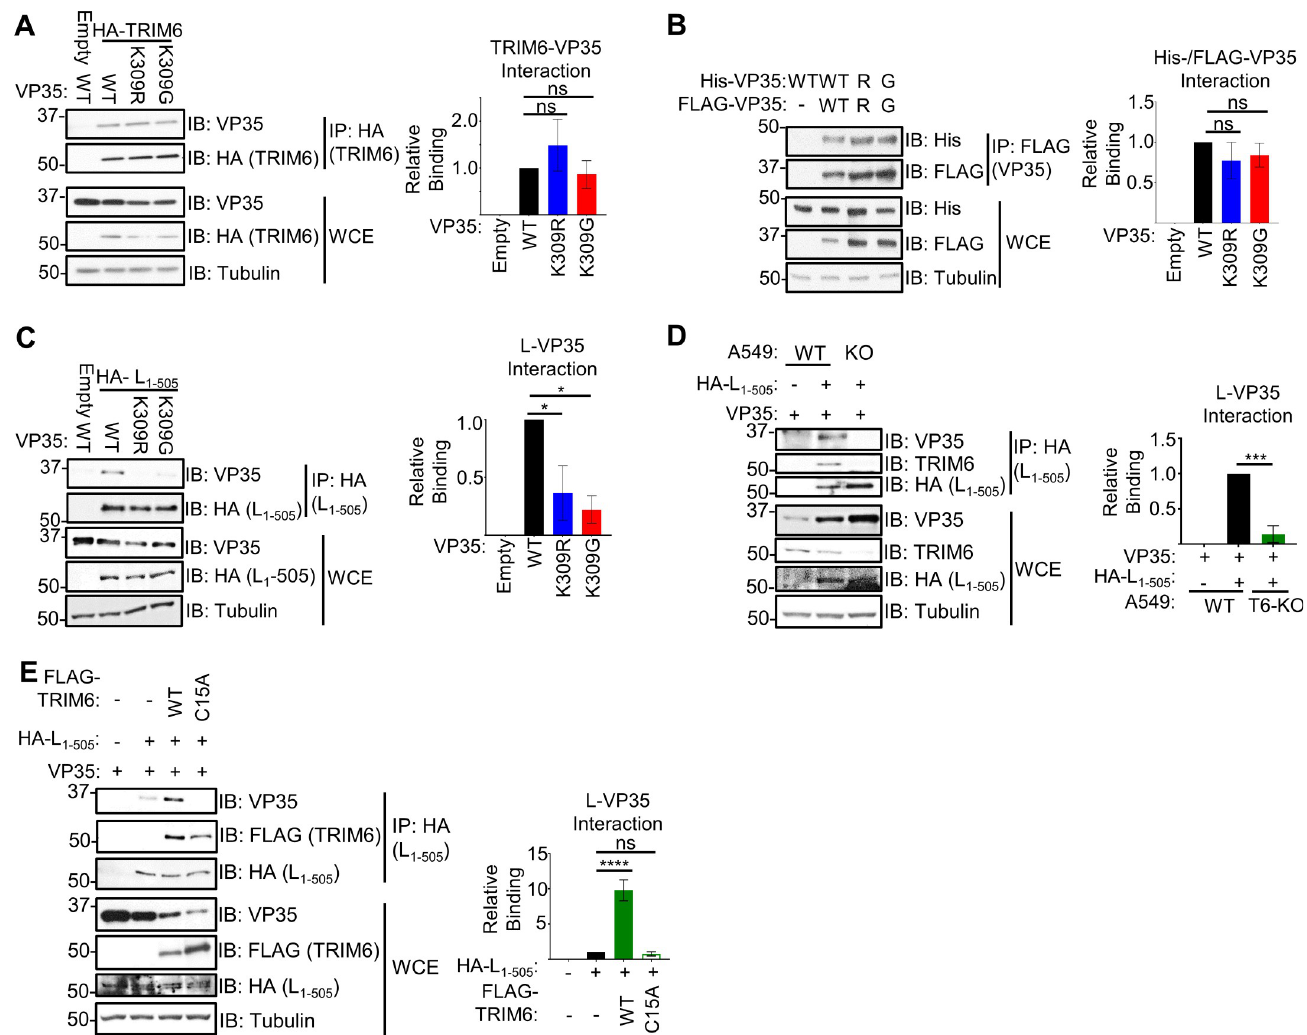
Fig 6. Mutation of VP35 at K309 dysregulates VP35’s interaction with the EBOV polymerase but not TRIM6 or itself. ( A ) Lysates (WCE) and HA- immunoprecipitation (IP) from 293T cells co-transfected with untagged VP35 (wt, K309R, or K309G) with HA-TRIM6 or pCAGGS (empty vector). The quantification is based on immunoblot densitometry (area under the curve) determined using ImageJ from three independent experiments. The binding ratio ((IP: VP35/HA-TRIM6)/(WCE: (VP35/HA-TRIM6)/Tubulin)) for each VP35 construct was divided by wt VP35’s ratio to determine relative binding. ( B ) 293T cells were co-transfected with His- or FLAG-tagged VP35 and FLAG IPs were performed. The quantification is based on AUC determined using ImageJ from three independent experiments. The binding ratio ((IP: His-VP35/FLAG-VP35)/(WCE: (His-VP35/FLAG-VP35)/Tubulin)) for each VP35 construct was divided by wt VP35’s ratio to determine relative binding. ( C ) WCE and HA-IP from 293T cells co-transfected with untagged VP35 (wt, K309R, or K309G) with HA-L 1-505 or empty vector. Immunoblot quantification from two independent experiments. The binding ratio ((IP: VP35/HA-L 1-505 )/(WCE: (VP35/HA-L 1-505 )/Tubulin)) for each VP35 construct was divided by wt VP35’s ratio to determine relative binding. ( D ) HA-L 1-505 and untagged wt VP35 were co-transfected into wt or TRIM6 knockout (T6-KO) A549 cells, and WCE were immunoprecipitated with anti-HA-tagged beads. The quantification is from data collected from three independent experiments. The binding ratio ((IP: VP35/HA-L 1-505 )/(WCE: (VP35/HA-L 1-505 )/Tubulin)) for lysates from wt and T6-KO cells was divided by the wt’s ratio to determine relative binding. ( E ) HA-L 1-505 and untagged wt VP35 were co-transfected with FLAG-tagged TRIM6 wt or -C15A or empty vector into T6-KO A549 cells, and WCE were immunoprecipitated with anti-HA-tagged beads. The quantification is from data collected from two independent experiments. The binding ratio ((IP: VP35/HA-L 1-505 )/(WCE: (VP35/HA-L 1-505 )/Tubulin)) for lysates from T6-KO cells transfected with empty vector, HA-TRIM6-wt, or -C15A was divided by the ratio of empty vector transfected cells to determine relative binding. The data analysis was done using a one-way ANOVA with Tukey’s post-test for comparison between groups ( A-E ). P-value: � < 0.05, �� < 0.01, ��� < 0.001, ���� < 0.0001; ns, not significant (p >